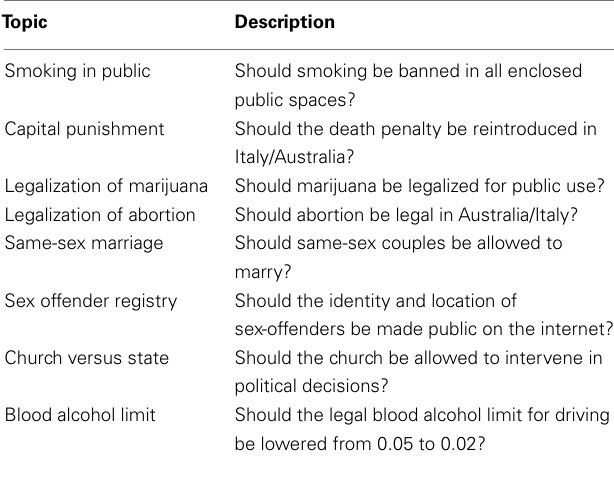
Table 1 |Topics addressed in social issues questionnaire (translated into English